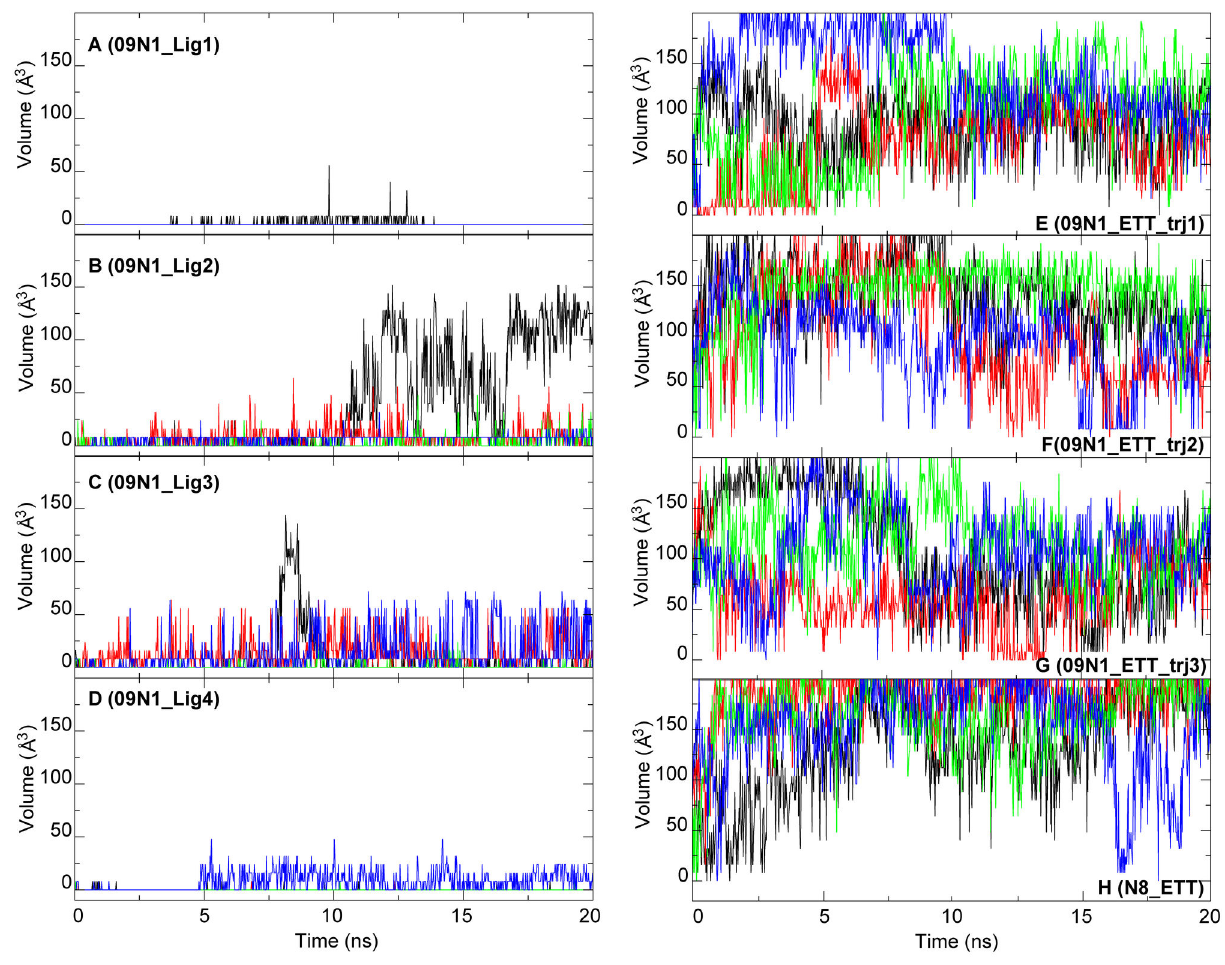
Figure 8. Volumes of the 150-cavity in different systems. The volumes of the 150-cavity in the systems with linked ligands are shown from panel A to D. Simulations of ETT bound in the 09N1 NAs were repeated 3 times, and the volumes of the 150-cavity in these systems are shown from panel E to G. The volume of the 150-cavity in N8 bound with ETT is shown in panel H. Lines colored in black, red, green and blue represented volume of the 150-cavity in protomer A to D for each complex system. doi: